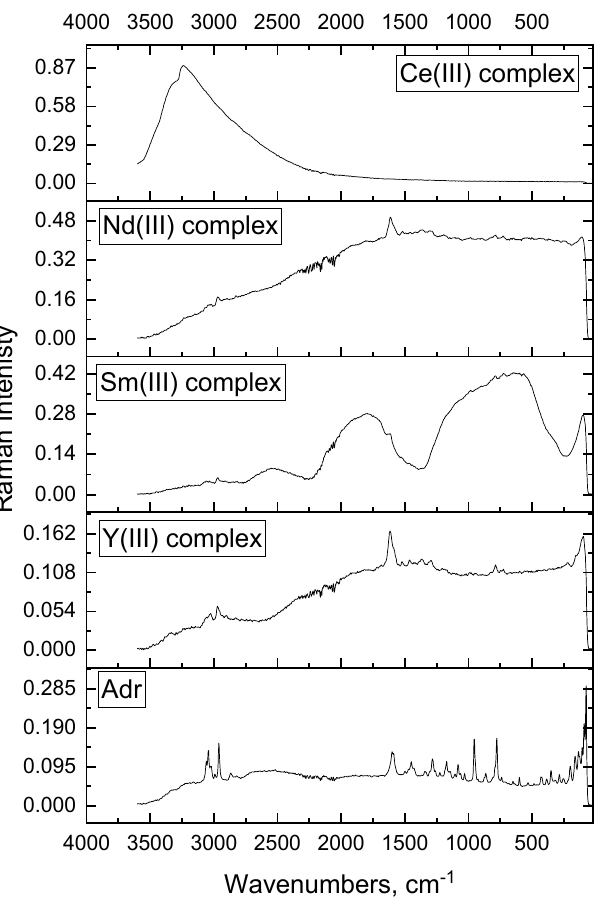
Figure 3. Raman spectra of [Y 2 (Adr) 2 (H 2 O) 8 ]Cl 3 · 8H 2 O, [Ce(Adr) 2 (H 2 O) 2 ]Cl 3 · 10H 2 O, [Nd(Adr) 2 (H 2 O) 2 ]Cl 3 · 6H 2 O, and [Sm(Adr) 2 (H 2 O) 2 ]Cl 3 · 12H 2 O adducts.